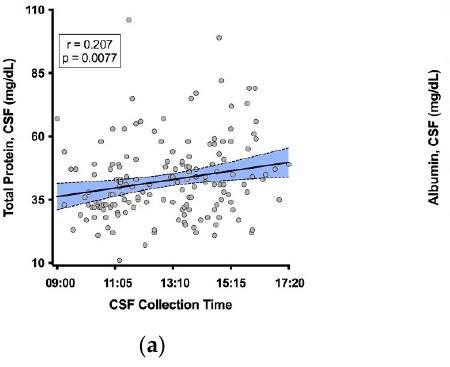
Figure 1. Later CSF collection time correlated with higher ( a ) CSF total protein, ( b ) CSF albumin, and ( c ) CSF globulin. Shaded area represents the 95% confidence band around the fit regression